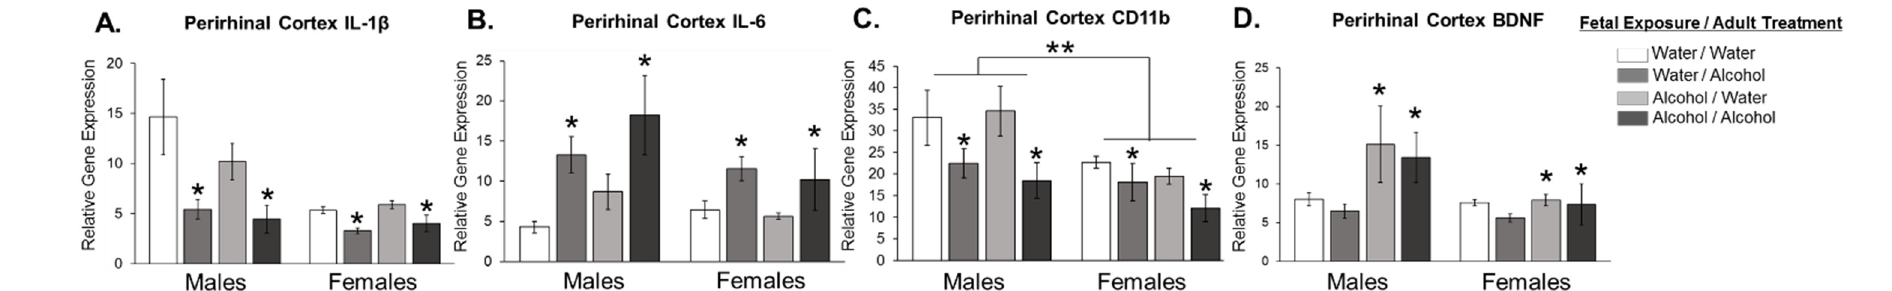
Figure 4. Perirhinal gene expression in male and female rats exposed to alcohol during fetal development, adulthood, or both. Pregnant dams were treated with alcohol or water on E10-17 (2 g/kg, 2 × /day). Offspring were allowed to grow up undisturbed at which point they were treated with either an acute dose of alcohol (4.5 g/kg, 2 × ) or water. Brain tissue was collected 2 h after the last dose of alcohol for the analysis of various cytokines and Brain Derived Neurotrophic Factor (BDNF). ( A ) Analysis of IL-1 β mRNA revealed a significant main effect of adult alcohol treatment ( F 1,47 = 10.316; * p = 0.003 compared to adult water treated controls) ( B ) Analysis of IL-6 mRNA revealed a significant main effect of adult alcohol treatment ( F 1,47 = 12.971;* p = 0.001 compared to adult water treated rats) ( C ) Analysis of CD11b mRNA revealed a main effect of adult alcohol treatment ( F 1,47 = 16.762; * p < 0.001 compared to adult water treated rats) and sex ( F 1,47 = 14.796; ** p < 0.001 in males compared to females).( D ) Analysis of BDNF mRNA in the perirhinal cortex revealed a significant main effect of prenatal alcohol exposure ( F 1,47 = 4.812; * p = 0.034 in rats exposed to alcohol prenatally compared to rats treated with water